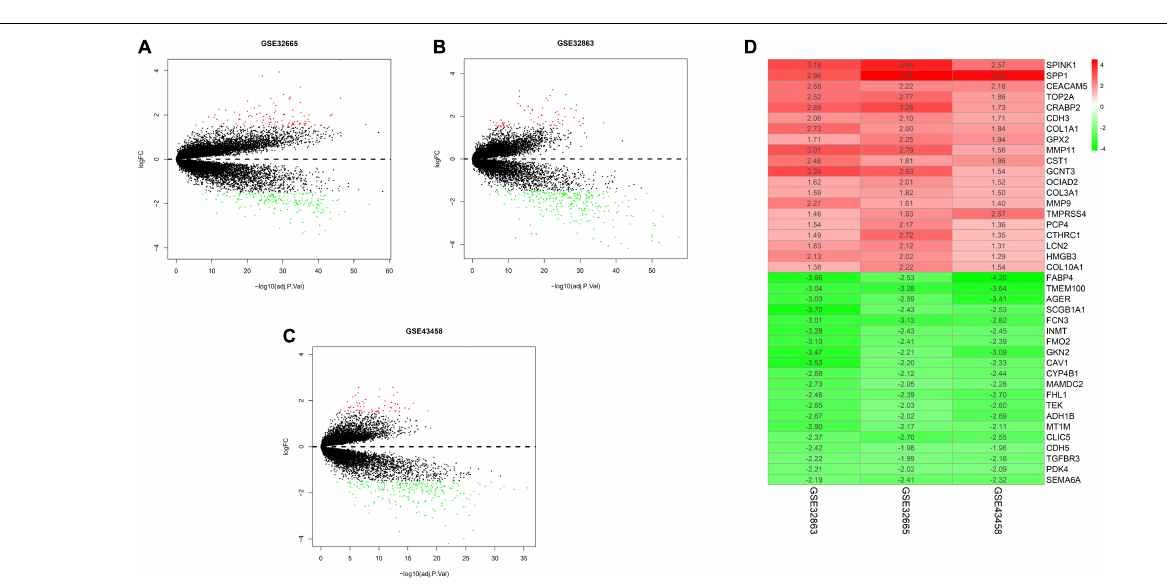
FIGURE 2 | Differential expression gene between normal and tumor tissue in three datasets, and heatmap of DEGs. (A) Volcano plot of GSE32665. The red points represent up-regulated genes, the green points represent down-regulated genes, and the black points represent genes without significant difference; (B) volcano plot of GSE32863; (C) volcano plot of GSE43458; (D) heatmap of top 20 up-regulated and down-regulated DEGs in three